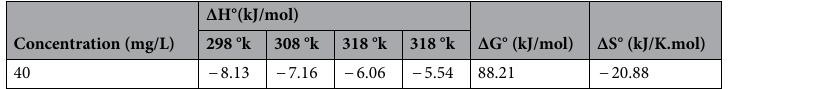
Table 4. Thermodynamic parameters for Cd(II) removal by the MBA nano-hybrid (pH = 7.0, adsorbent = 1.0 g/L, temperature = 25 °C, time = 60